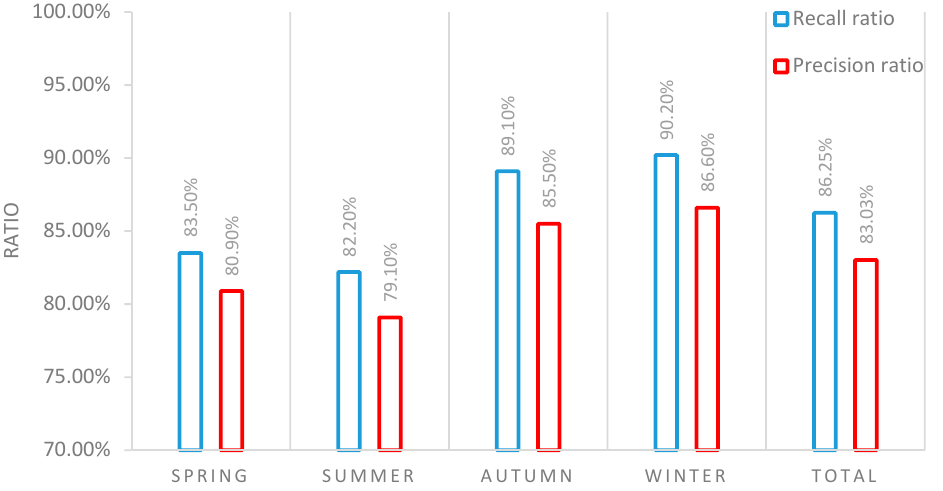
Figure 9. Recall ratio and precision ratio of the trough line analysis, classified according to season.